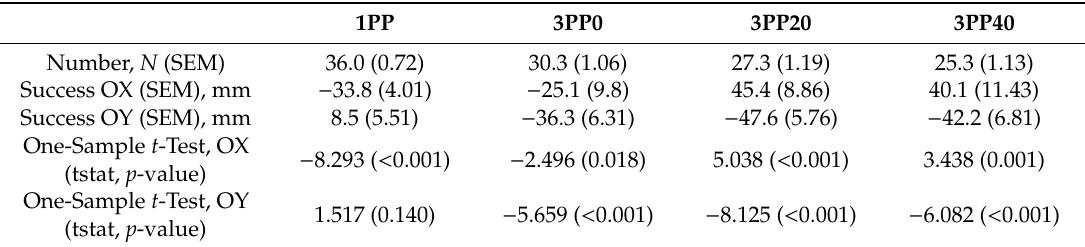
Table 1. The number of throws and the Mean (SEM) of the hit success along the OX and OY axes in